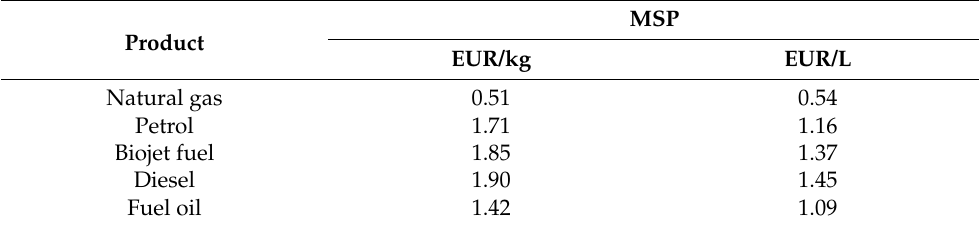
Table 19. MSP of biofuels for the studied process.